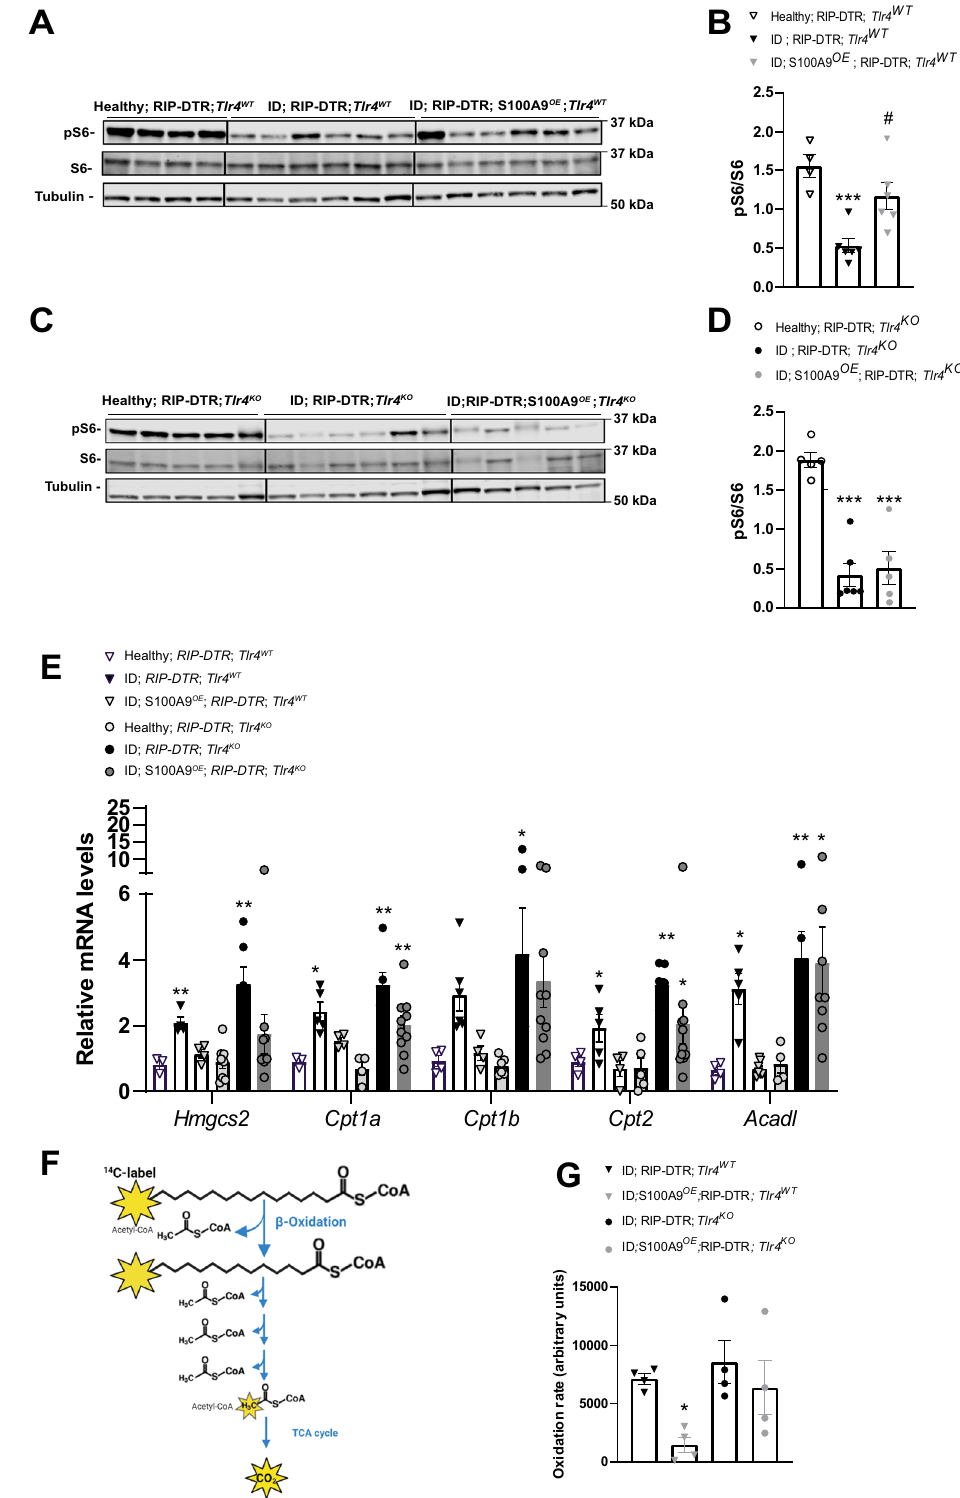
recombinase under the control of the thyroid hormone binding globulin (TBG) promoter (Adenovirus-TBG-Cre/GFP), and hence delivering Cre-recombinase solely in hepatocytes 53 . We generated Tsc1 fl / fl ID mice and infected them with either Adenovirus-TBG-Cre (referred to as Tsc1 HEP-KO mice) or Adenovirus-TBG-GFP (referred to as Tsc1 fl / fl mice) (Fig. 4A, B). Widespread expression of Adenovirus-TBG-GFP was